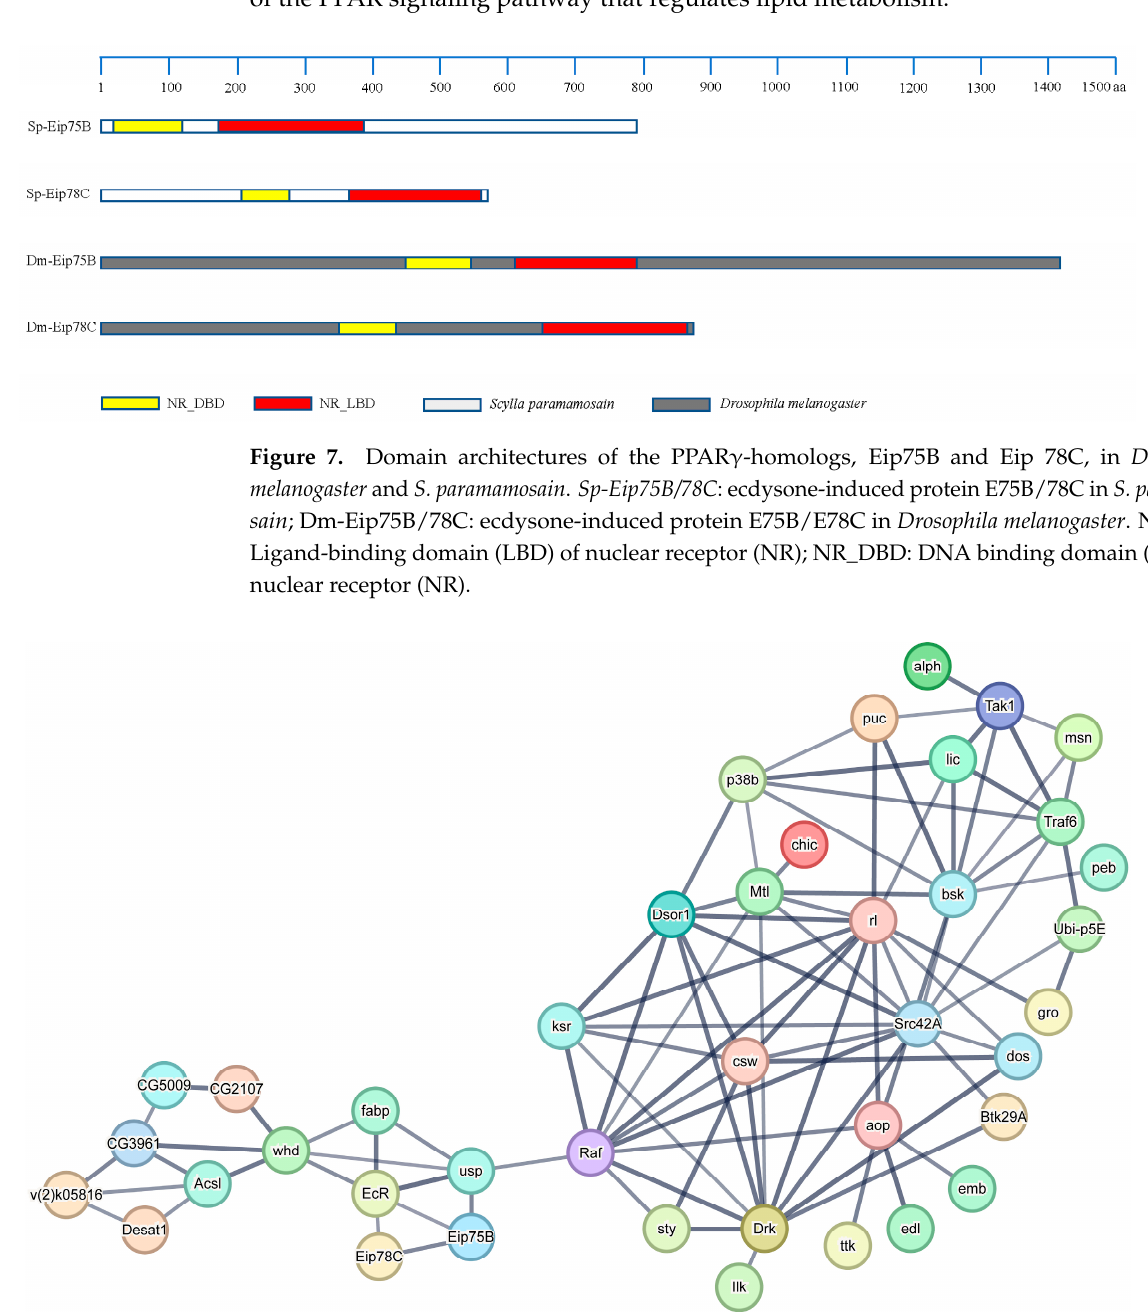
Figure 8. Protein-protein interaction network of MAPK and PPAR signaling pathways. All the information of the proteins in the network are listed in the Supplementary File Table S5.